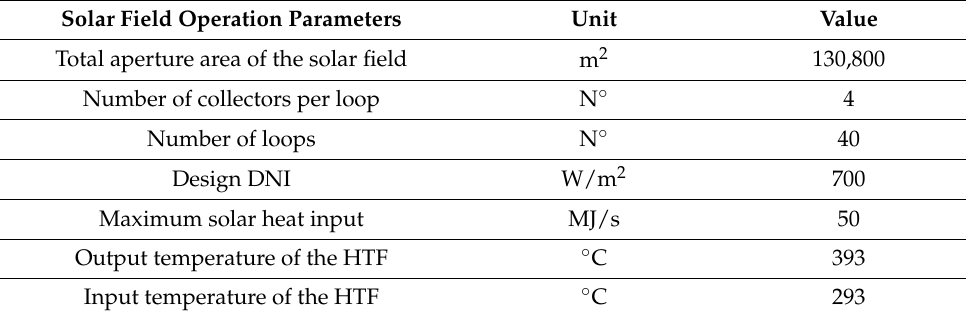
Table 3. The solar field design parameters